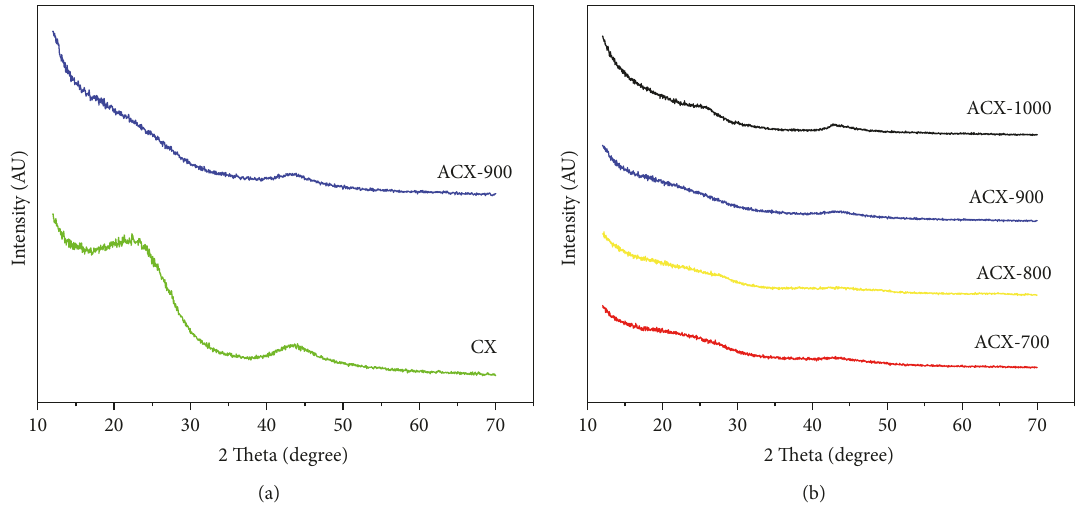
Figure 4: XRD patterns of (a) CX and ACX-900 and (b) ACX-700, ACX-800, ACX-900, and ACX-1000.